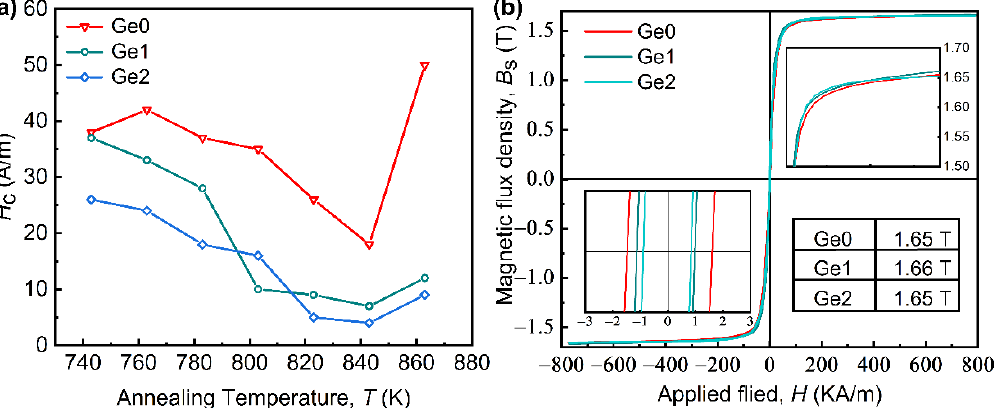
Figure 3. H c of the Fe 80.2 Si 3 B 12- x P 2 Nb 2 Cu 0.8 Ge x ( x = 0, 1, 2 at.%) alloy ribbons annealed at different T A by conventional annealing ( a ) and hysteresis loop and B s of the alloys annealed by conventional annealing (843 K, 10 min) ( b ).